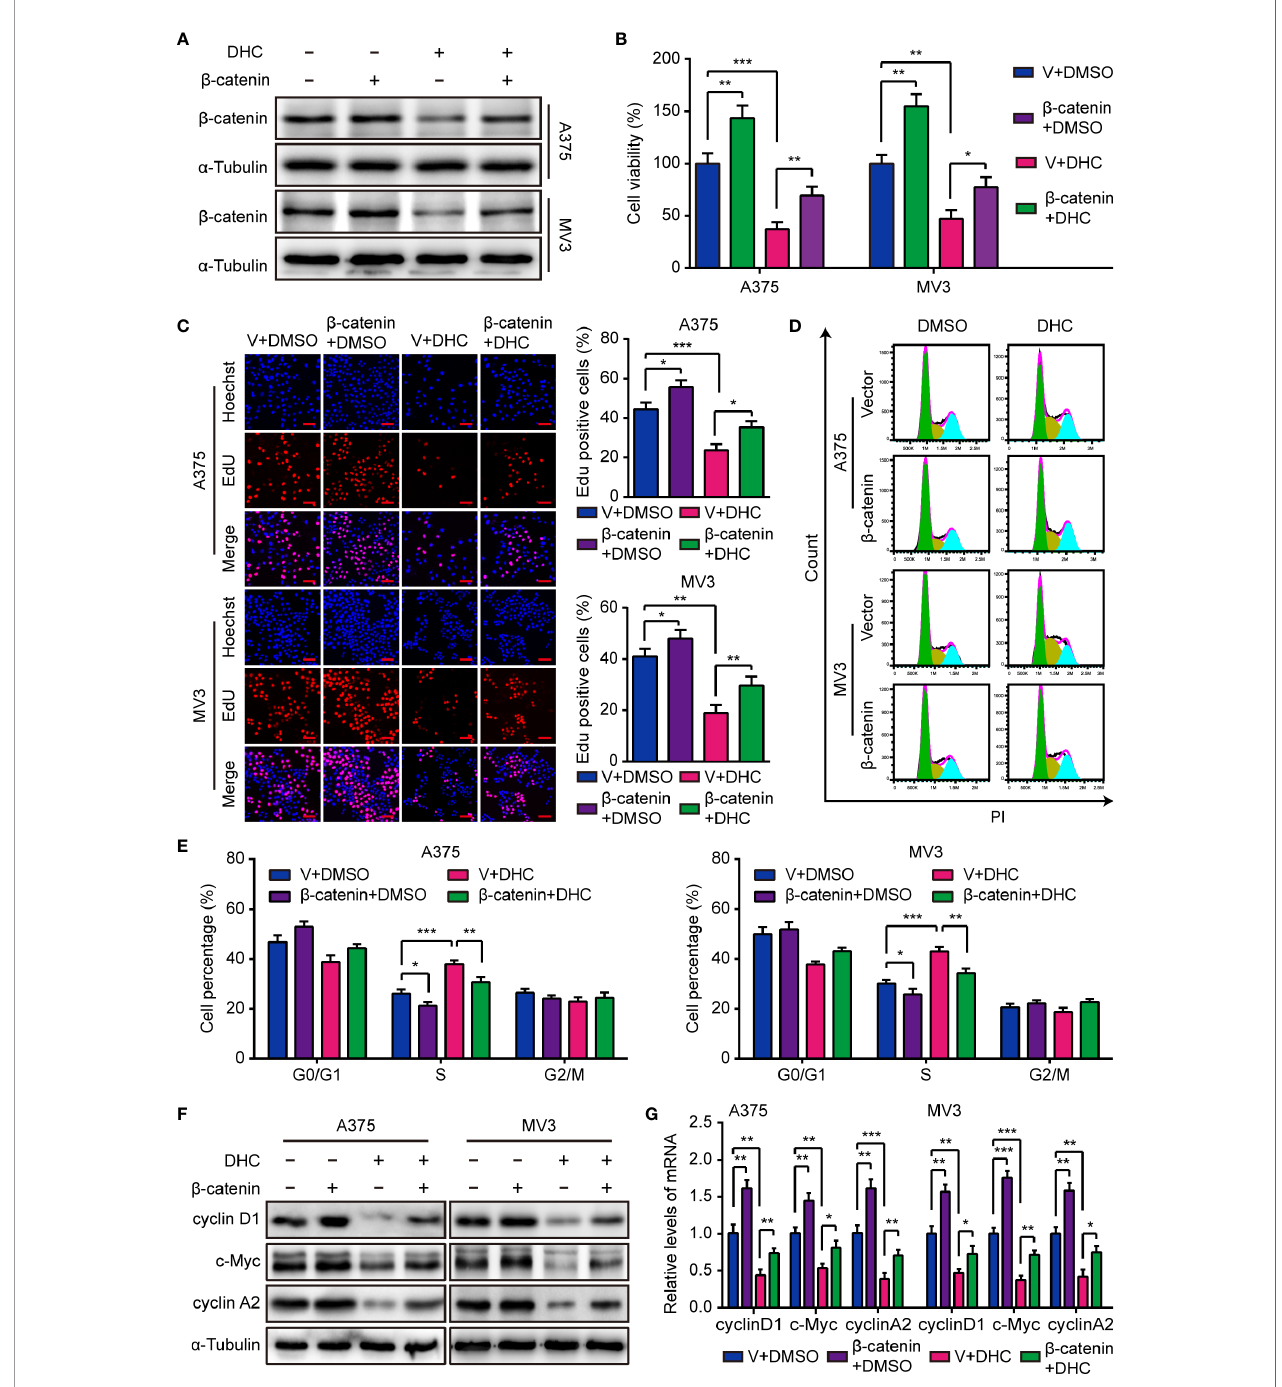
FIGURE 4 | Overexpression of b -catenin retrieves DHC-induced cell proliferation inhibition. (A) The protein expression of b -catenin in b -catenin/vector overexpressed A375 and MV3 cells treated with 100 m M DHC for 48 h. (B) Cell viabilities of b -catenin/vector overexpressed A375 and MV3 cells treated with 100 m M DHC for 48 h. (C) EdU staining of b -catenin/vector overexpressed A375 and MV3 cells treated with 100 m M DHC for 48 h. (D, E) Cell cycle analysis of b -catenin/ vector overexpressed A375 and MV3 cells treated with 100 m M DHC for 48 h. (F, G) The protein and mRNA levels of cyclin D1, c-Myc, and cyclin A2 in b -catenin/ vector overexpressed A375 and MV3 cells treated with 100 m M DHC for 48 h. * P <0.05; ** P <0.01; *** P <